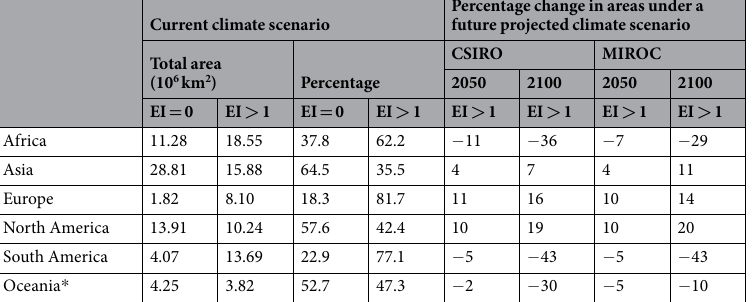
Table 2. Projected areas of unsuitability and suitability for maize by continent under current climate conditions and percentage of areas. Percentage values indicate changes in the suitability of areas under future projected climate from the current climate. * Oceania = Australia and New Zealand. EI = 0 is unsuitable area. EI > 1 includes three suitable categories (marginal, medium and optimal). Note that these are the total suitable projected areas and not the actual areas under maize